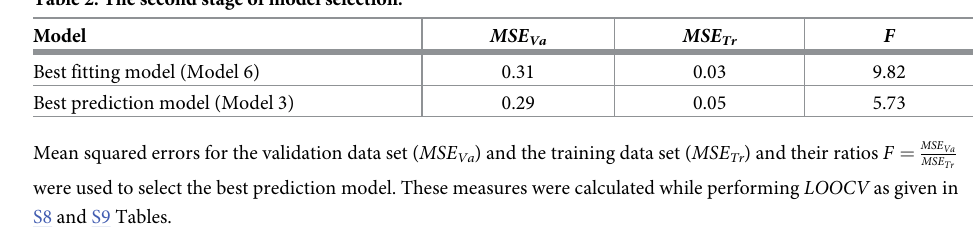
Table 2. The second stage of model selection.